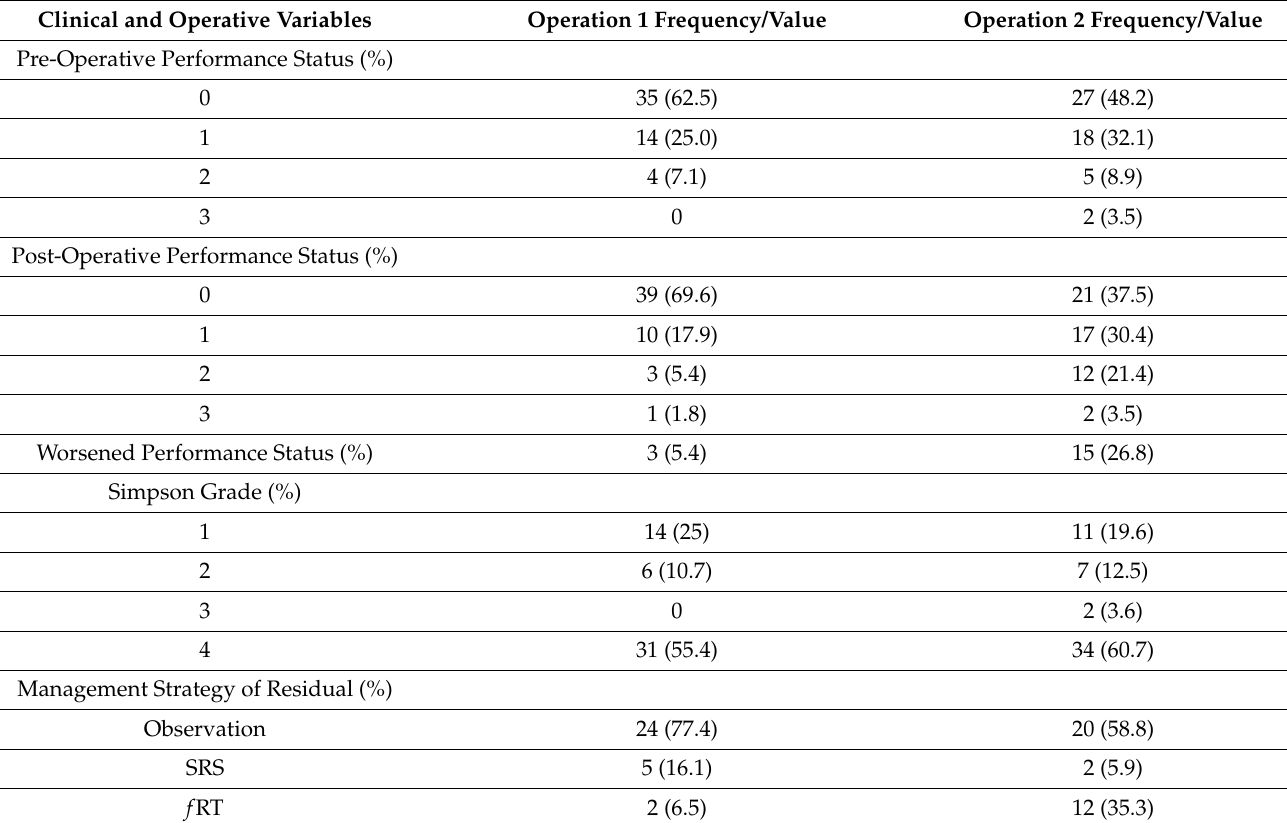
Table 2. Contains clinical and operative details for the first and second